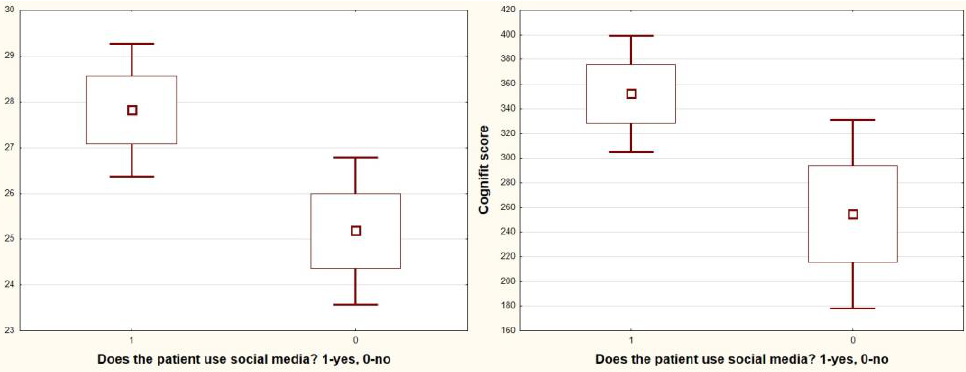
Figure 5. Box-whisker graph of CompBased-CAT (Cognifit score) and MOCA vs. HD session activity.